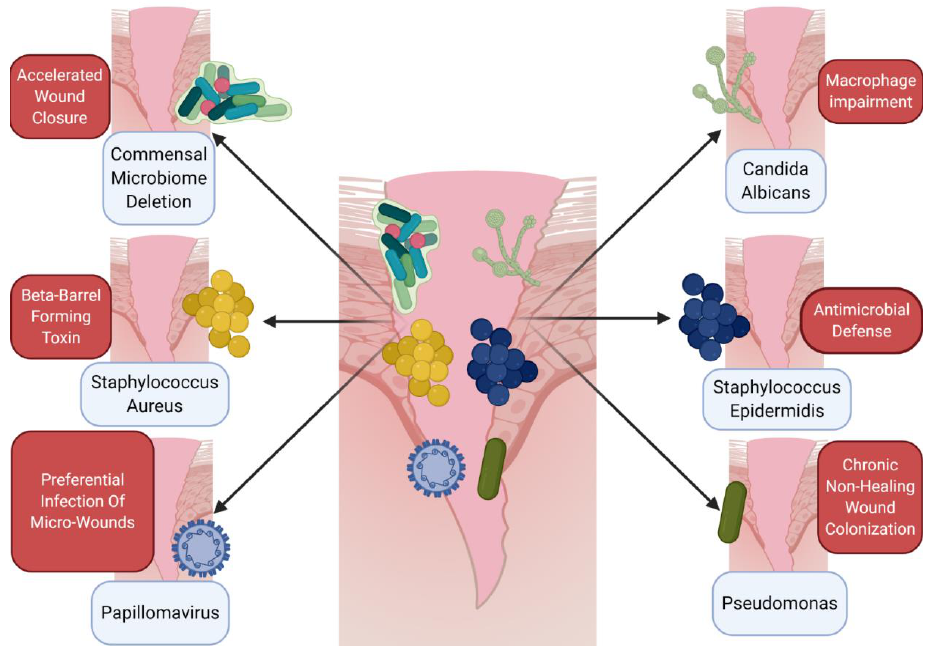
Figure 1. Host–microbe cross talk informs the immune microenvironment of wounds. A number of di ff erent microbes, including various bacteria, viruses, and fungi, can directly impact wound healing and alter the immune microenvironment. Upon wounding, whether by trauma, arthropod bite, or chronic barrier disruption, skin-resident bacteria, viruses, and fungi all can impact the microenvironment of the healing tissue. Several general and specific examples of this microenvironment interaction have been elucidated recently. Paradoxically, germ-free mice exhibit accelerated wound closure when compared to conventionally raised mice [54]. Other specific microbes have distinct e ff ects on immune cells, including Staphylococcus aureus , which creates beta-barrel forming toxins to impair macrophage function in the wound [58], or Candida albicans , which also disrupts normal macrophage action [59]. While not a direct immune cell e ff ect, other pathogens can impact the microenvironment, hijacking or colonizing wounds directly, including papillomavirus [60] and Pseudomonas species [61]. Skin commensal microbes